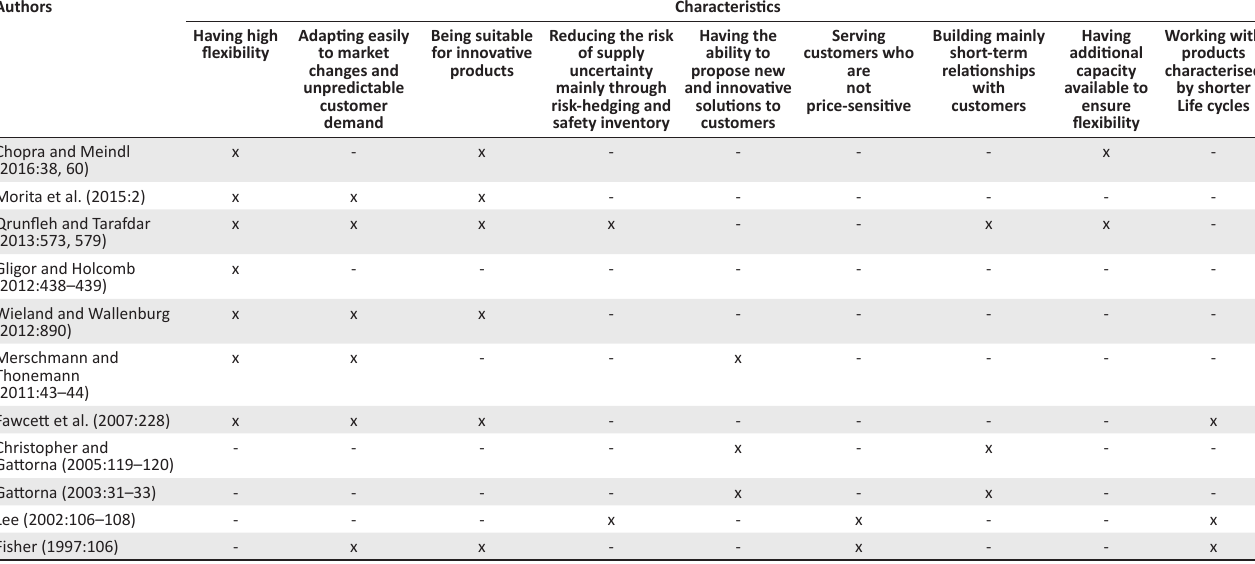
TABLE 1: Characteristics of a supply chain strategy orientated towards responsiveness based on literature.